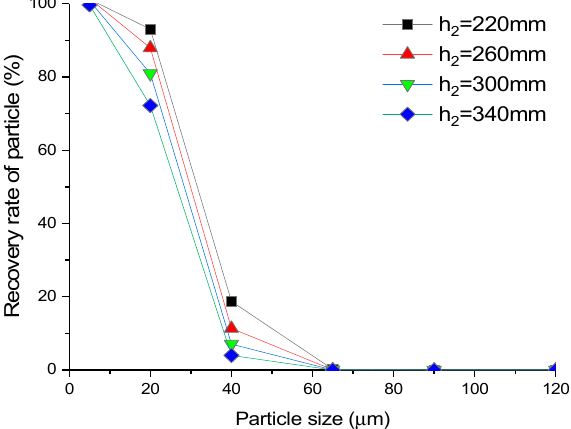
Figure 11. E ff ect of column height on the recovery rate of overflow Figure 11. Effect of column height on the recovery rate of overflow particles. Figure 11. Effect of column height on the recovery rate of overflow particles.